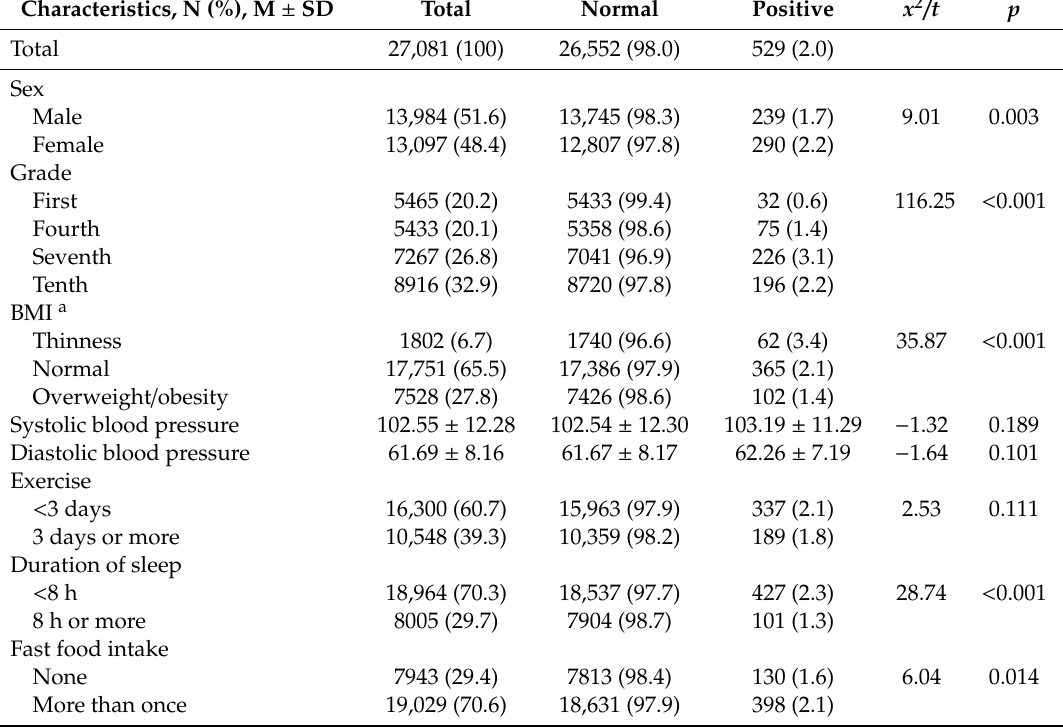
Table 1. Proteinuria by individual characteristics (N = 27,081).